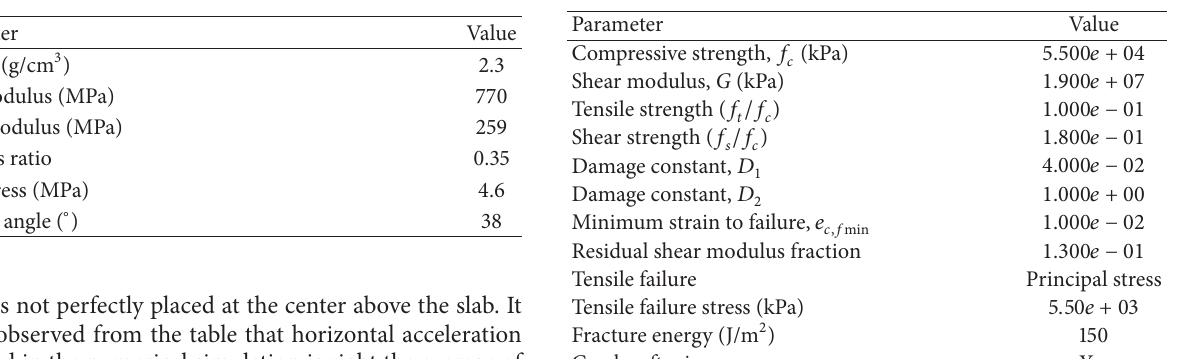
Table7:ParameterofasphaltmaterialusingDrucker-Pragermodel. Table 8: Parameters of HSC in the RHT model.